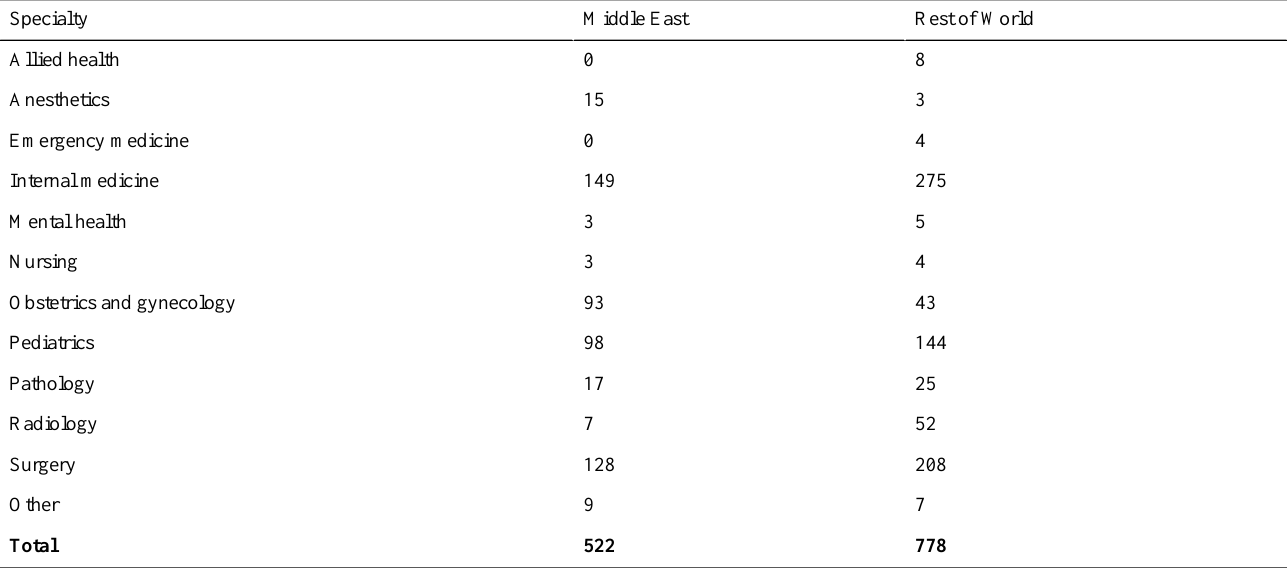
Table 2. Types of queries for the cases referred from July 2004 to June 2007